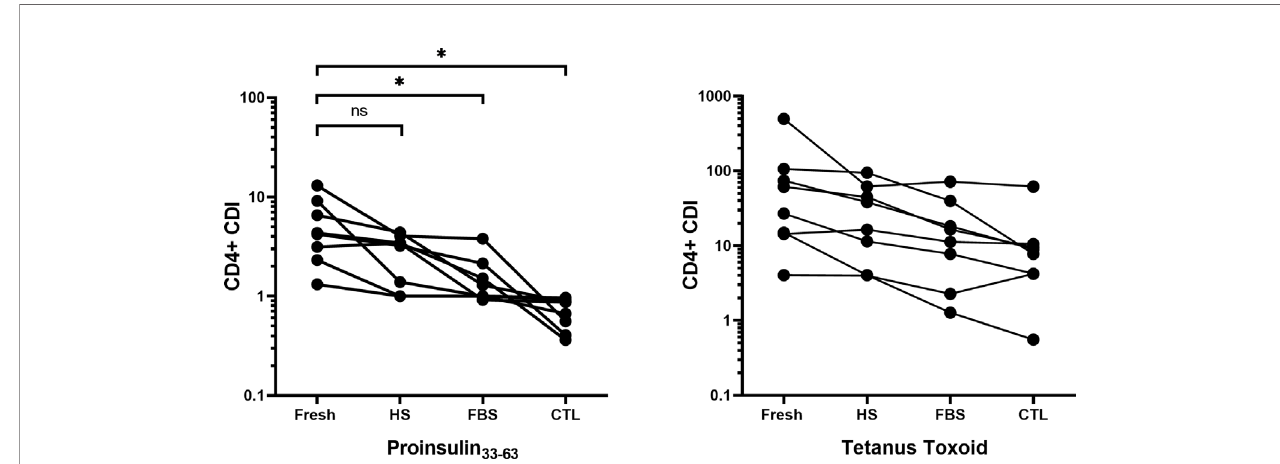
FIGURE 5 | Comparison of the CD4 + T-cell division index using freshly isolated PBMCs cryopreserved in FBS/10% DMSO, HS/10% DMSO or serum-free CTL media, measured with the CFSE-based T-cell proliferation assay for eight different patients. Seven days after cryopreservation, frozen PBMCs were thawed and incubated without peptide, or with PI 33-63 , tetanus toxoid or anti-CD3 antibody. CDI for each freezing media was compared to CDI for fresh PBMCs: *p < 0.05 paired t test. Fresh, Freshly isolated PBMC; HS, Human Serum; FBS, Fetal Bovine Serum, CTL, CTL Cryo ™ solution